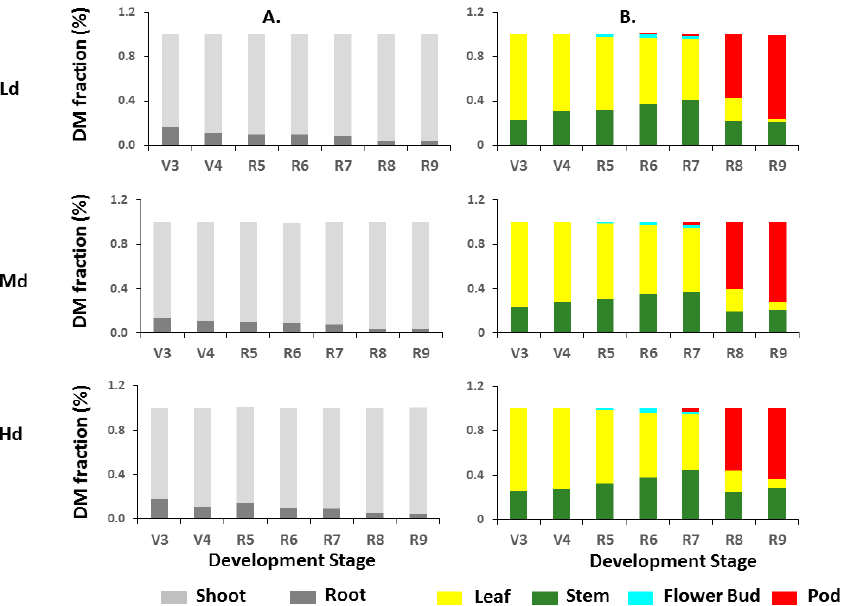
Figure 7. Average fractions ( A ) of roots and shoots in total biomass and ( B ) distribution of shoot biomass over leaves, stems, flower buds and pods of growth habit I Azufrado 2 dry bean ( Phaseolus vulgaris L.) cultivar established at 90,000 plants ha − 1 (Low density, Ld), 145,000 plants ha − 1 (Medium density, Md) and 260,000 plants ha − 1 (High density, Hd) under rainfed conditions during the 2011 growing season in Pabellon de Arteaga, Aguascalientes, Mexico.